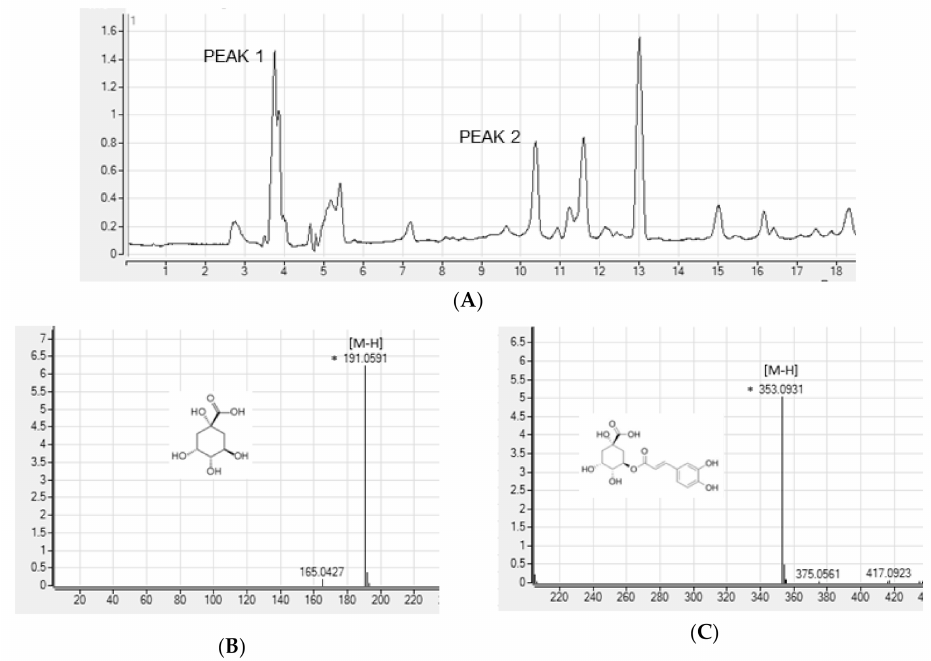
Figure 1. High-performance liquid chromatography (HPLC) chromatograms ( A ) and positive ion MS spectra ( B , C ) of Aster scaber ethanolic